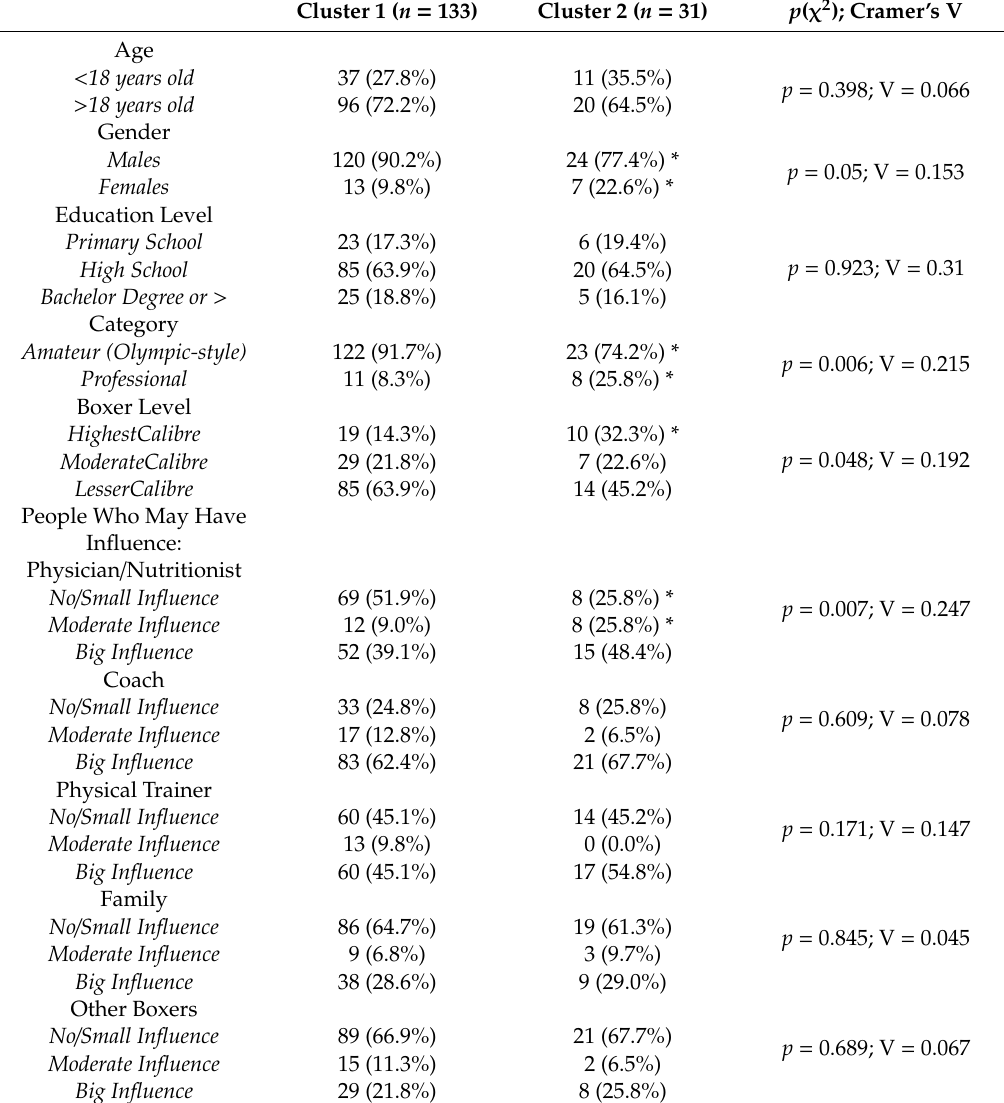
* stars indicate rows whose column percentages are significantly di ff erent from each